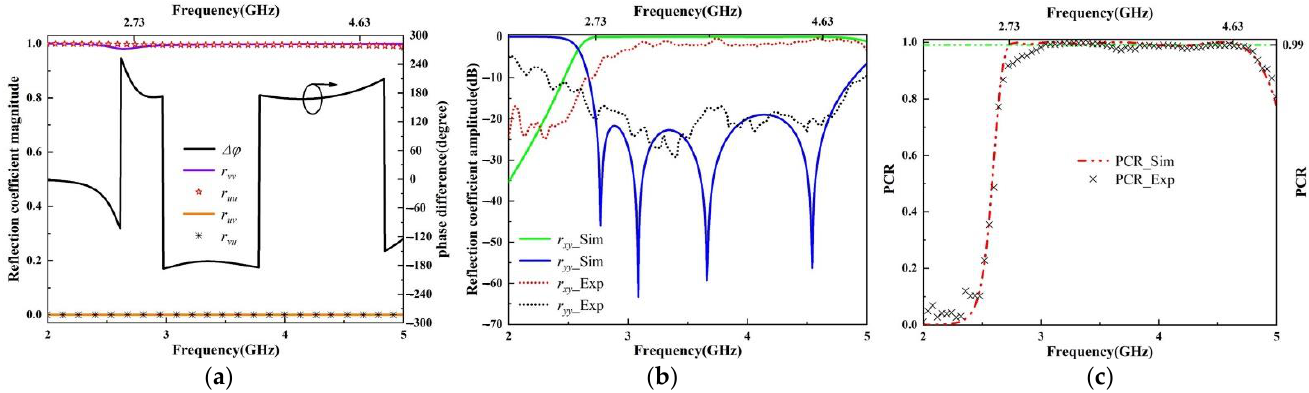
Figure 2. Normal incidence results of the proposed model. ( a ) Reflection coefficient amplitudes and phase differences in u – v coordinate system. ( b ) Reflection coefficient amplitudes in the x - y coordinate system. ( c ) PCR.